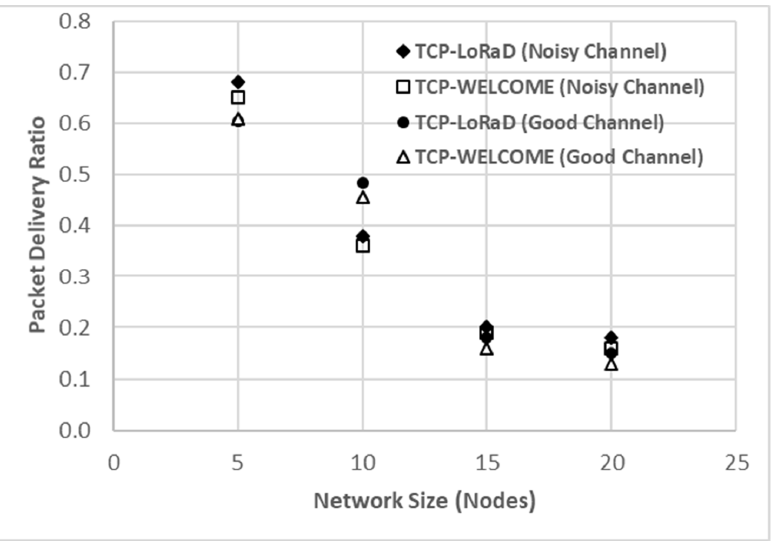
Figure 7. Packet Delivery Ratio versus increasing number of nodes in a noisy channel. Comparison of TCP-LoRaD and